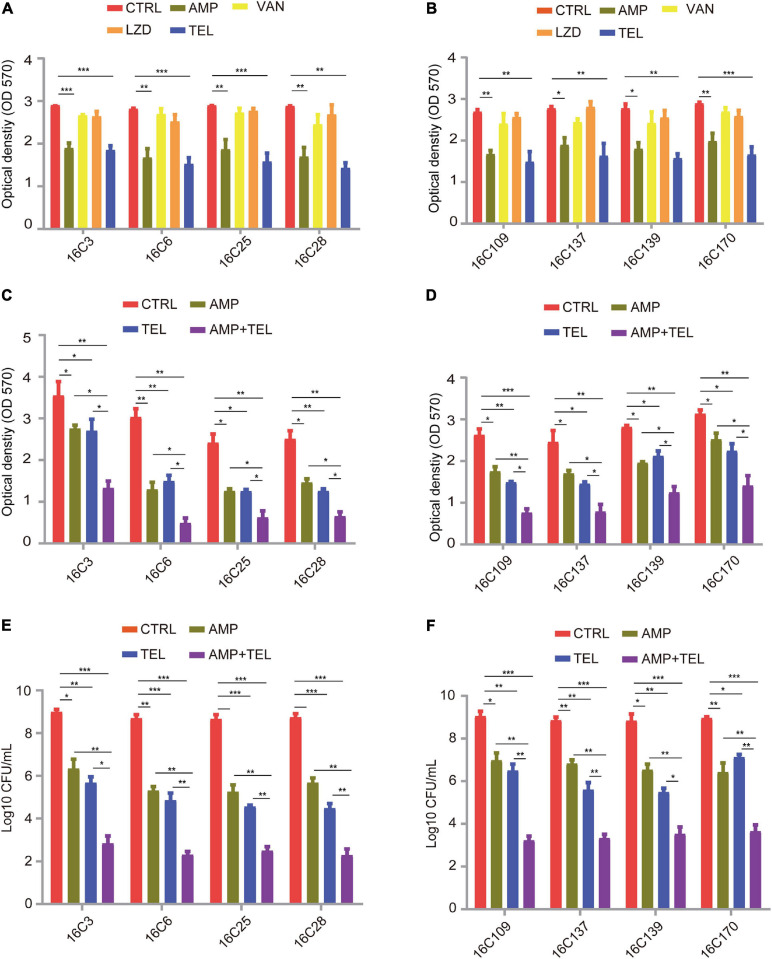
Telithromycin alone or combined with ampicillin eradicating the established biofilms of eight E. faecalis isolates. (A,B) A total of eight isolates formed mature biofilms for 24 h, then treated with AMP, VAN, LZD, or TEL at 8 × MICs for 48 h. The MICs of AMP, VAN, and TEL for these isolates were 2, 1, and 8 μg/mL, respectively. The MICs of LZD for 16C3, 16C6, 16C25, and 16C28 isolates were 4 μg/mL, the MICs for 16C109, 16C137, 16C139, and 16C170 were 2 μg/mL. (C,D) A total of eight isolates formed mature biofilms for 24 h, then were treated with AMP and TEL alone or TEL combined with AMP at 8 × MICs for 48 h. The MICs of AMP and TEL for these isolates were 2 and 8 μg/mL, respectively. (E,F) A total of eight isolates formed mature biofilms for 24 h, then were treated with AMP and TEL alone or TEL combined with AMP at 8 × MICs for 48 h. Then the adherent cells in these established biofilms were detected by the CFU numbers. The MICs of AMP and TEL for these isolates were 2 and 8 μg/mL, respectively. TSBG without antimicrobials was used as an untreated control throughout. The data were presented as the mean ± SEM (n = 3 experiments), one-way analysis of variance (ANOVA), and post hoc-Dunnett test, *p < 0.05, **p < 0.01, ***p < 0.001, compared with the CTRL group.